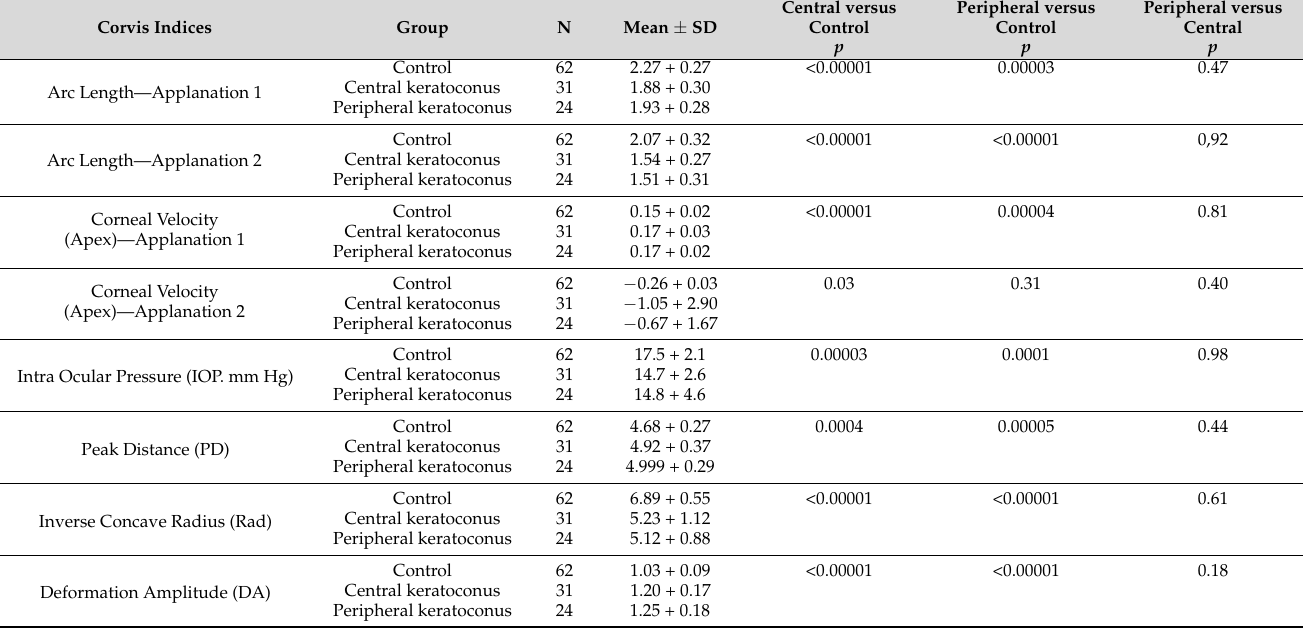
Table 4. Analysis stratified according to the location of the thinnest